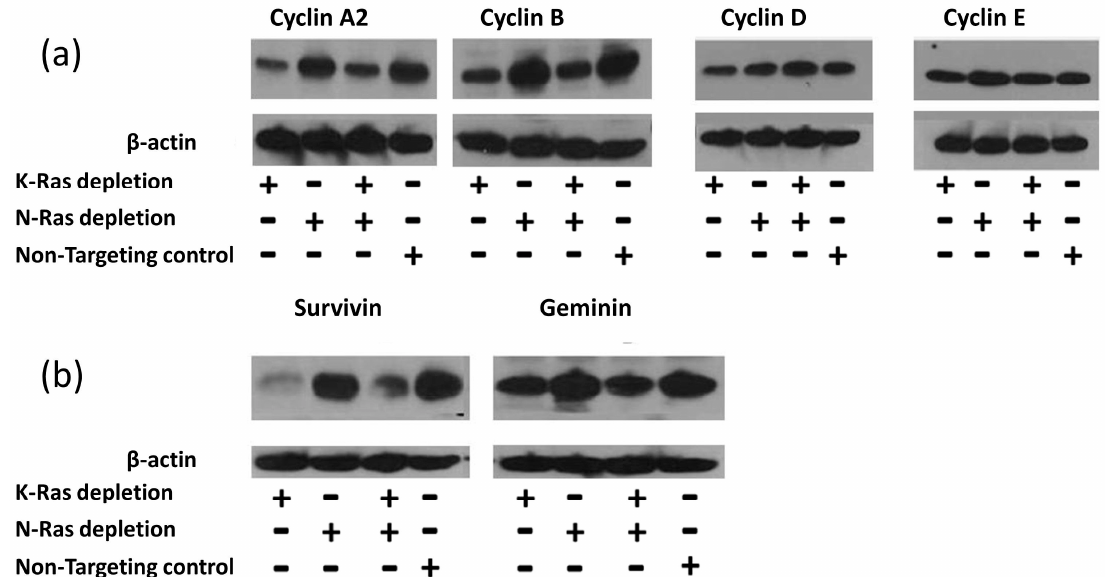
Figure 2. Effect of K-Ras depletion on G2 cyclins and other APC/c targets. ( a ) Western blot analysis of Suit-2 cells treated with K-Ras, N-Ras, or non-targeting siRNA showing the levels of cyclins. ( b ) Other targets of the APC/c complex and their levels following siRNA treatment.